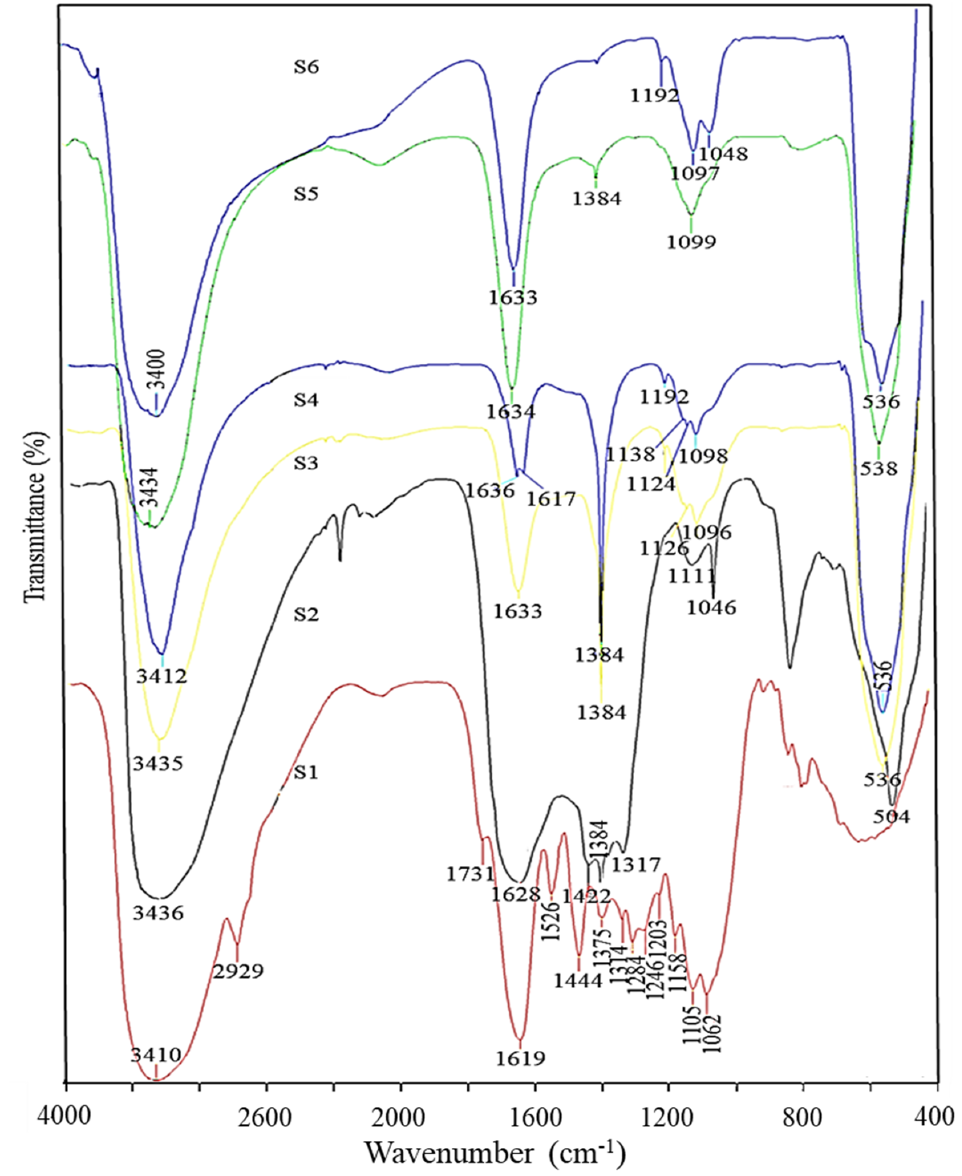
Figure 4. FTIR spectrum for S1 = mangosteen leaf extract, S2 = CuO NPs calcinated at 200 °C, S3 = CuO NPs calcinated at 300 °C, S4 = CuO NPs calcinated at 400 °C, S5 = CuO NPs calcinated at 500 °C and S6 = CuO NPs calcinated at 600 °C.